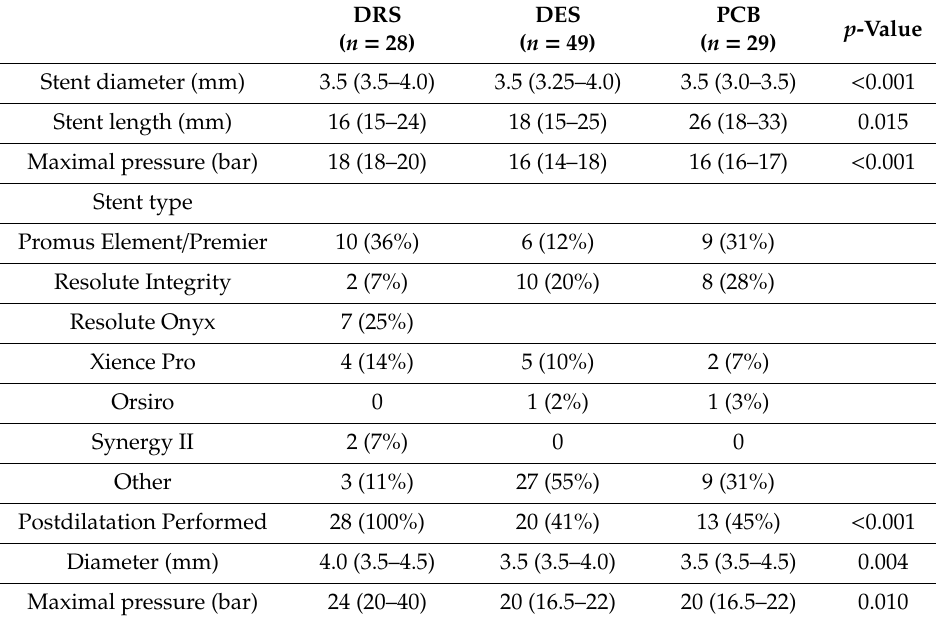
Table 4. Procedural Characteristics of the Initial